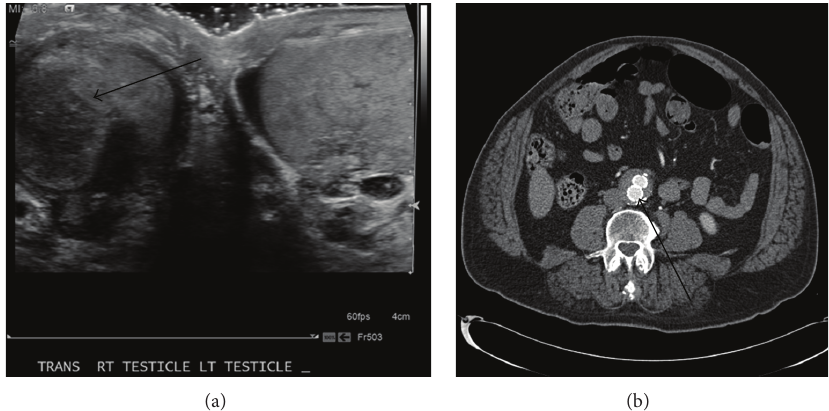
Figure 1: (a) Testicular ultrasound demonstrating decreased echogenicity within the right testicle (arrow). (b) Computed topographic angiogram (CTA) showing endovascular stent graft